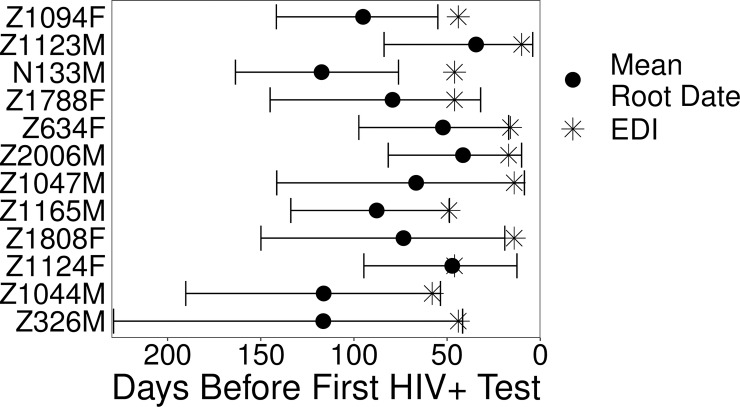
Bayesian root date estimation.Bayesian inference was used to estimate the root date, or time of infection, from pre-therapy plasma env sequences. The 95% highest posterior density intervals surround the mean estimated root dates of the Bayesian inference (circles). The clinically estimated infection dates (EDIs) are depicted as stars.